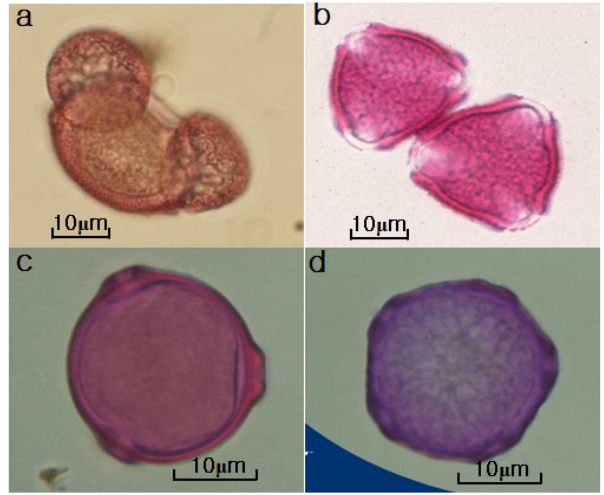
Fig. 6. Microphotographs of pollen grain observed in this study: